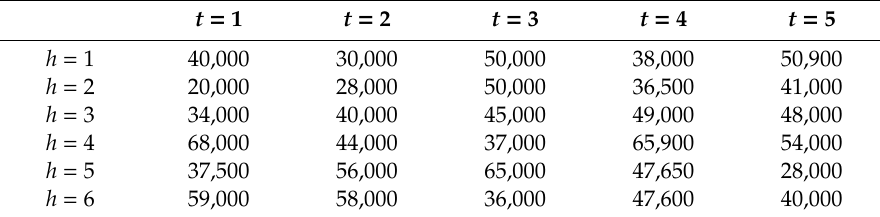
Table 9. Annual forecasted demand (units) of each hospital in each time period.